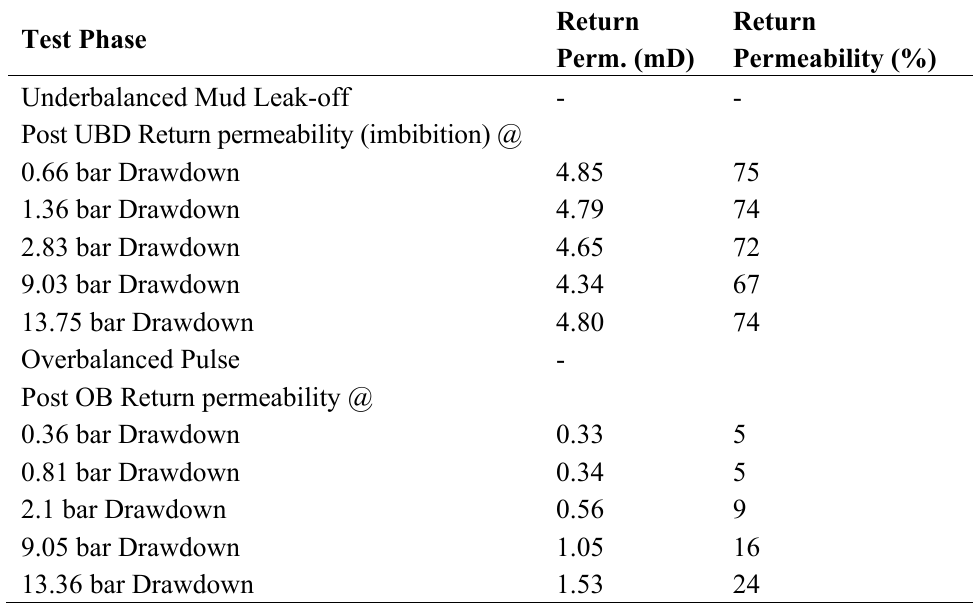
Table 9. Leak-off test with fresh water; sample D, Permeability Summary.